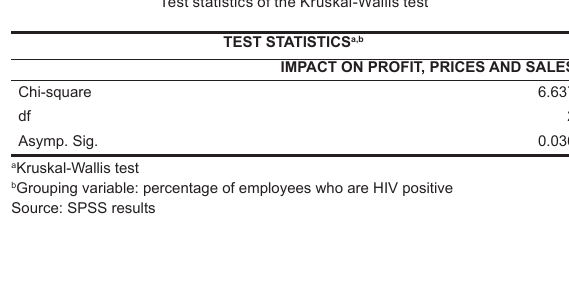
TABLE 23 Test statistics of the Kruskal-Wallis